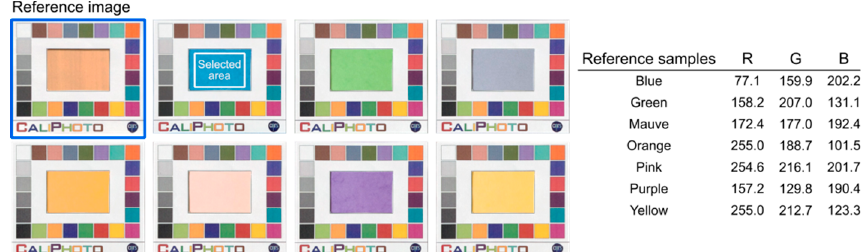
Figure A10. Constitution of a CaliPhoto database of coloured paper. Reference image used for the CaliPhoto image processing correction and corrected images of the reference samples. The areas corresponding to the samples are selected, and the average colours are calculated and stored in a database, as shown in the table.